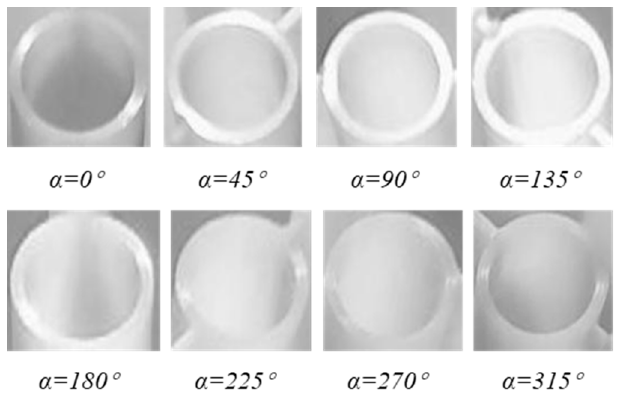
Figure 12. Drive bore templates intercepted for direct template matching.